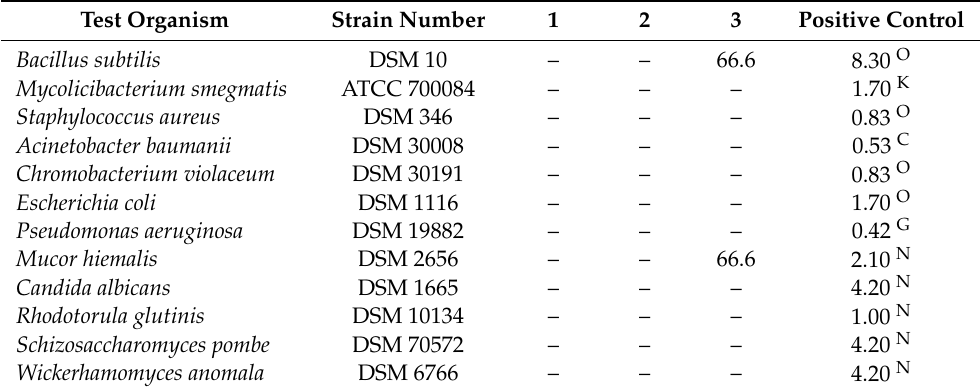
Table 3. Minimum inhibitory concentration (MIC, µ g/mL) of 1–3 against bacterial and fungal test organisms.